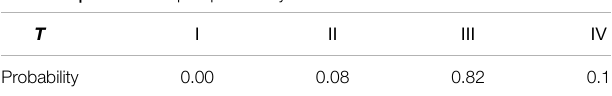
TABLE 7 | Tunnel collapse